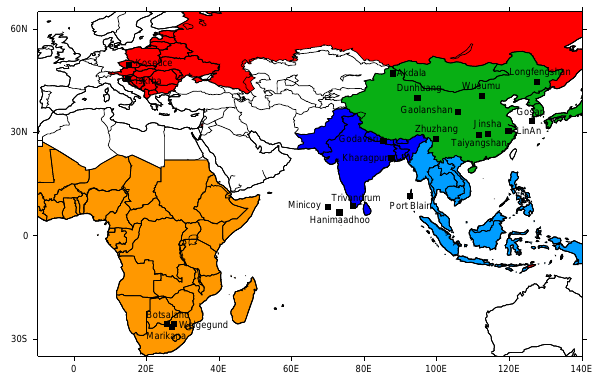
Figure 2. Locations of aerosol measurements used in this study and geographical regions of Eastern Europe and the Russian Federa- tion (red), Africa (orange), South Asia (dark blue), Southeast Asia (light blue), and East Asia (green). Note that geographical regions are only used to distinguish difference in mortality across different regions (see Sect.